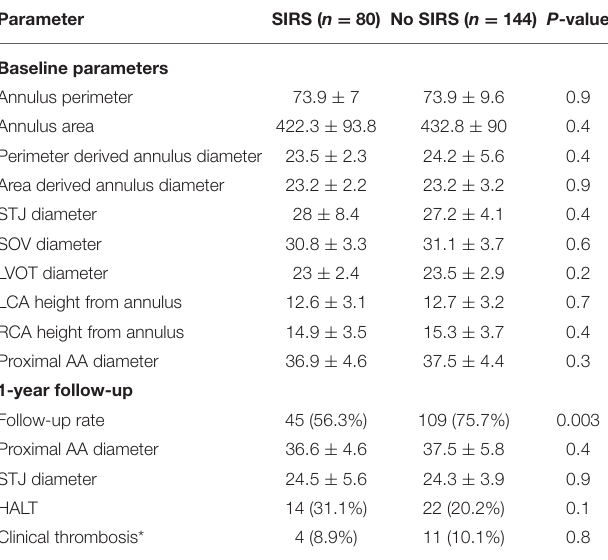
TABLE 4 | Baseline and 1-year follow-up CT angiographic findings. Parameter Baseline parameters